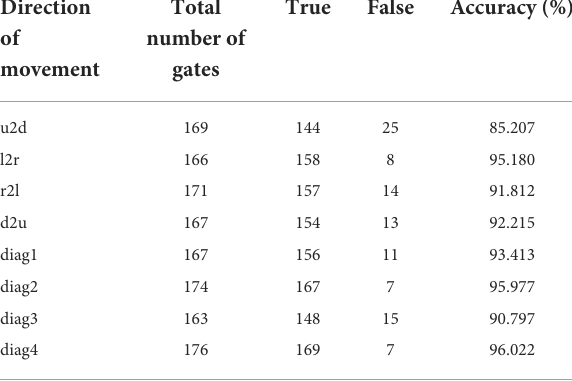
TABLE 1 The details of the best performing models. Mov. type Test data Balanced acc Sense Spec Truth table